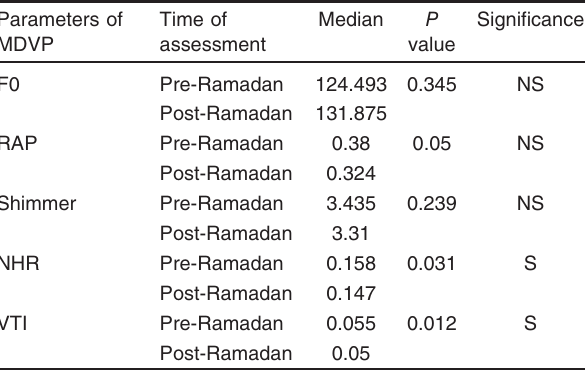
Table 7 Comparison between the results of multidimensional voice program parameters pre-Ramadan and post-Ramadan assessments for the group that received voice hygiene advices Parameters of MDVP